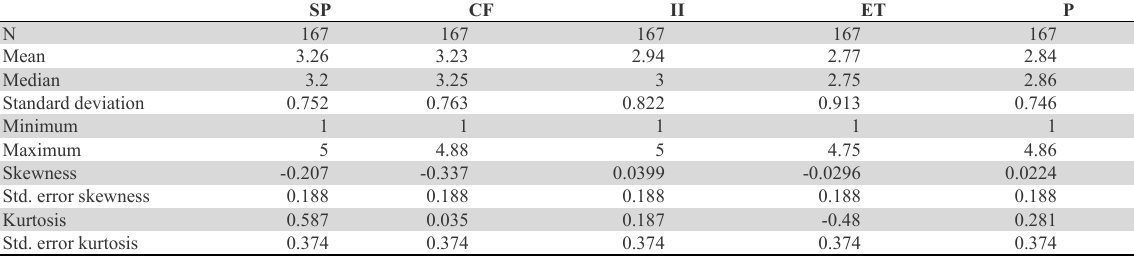
Mean, Standard Deviation, Skewness, and Kurtosis of Constructs (N = 167)